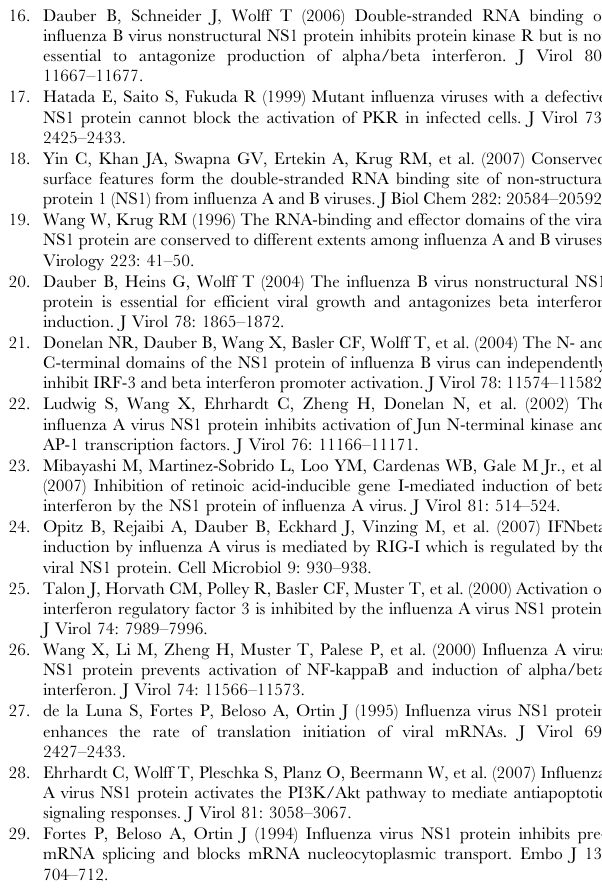
Figure S1 Pathogenicity of influenza B viruses expressing dsRNA-binding defective NS1 proteins is enhanced in PKR null mice. (A) Groups of eight-week-old female PKR 2 / 2 and wild type C57B6 mice were anesthetized and infected intranasally with 1 6 10 5 pfu of the indicated recombinant influenza B/Lee virus. For monitoring of viral disease, 8 animals were weighed daily for two weeks, and mean percentage weight loss of each group was compared with the weight immediately prior to infection. Mice were euthanized when observed in extremis. (B) Survival rate of PKR 2 / 2 mice after infection with recombinant influenza B viruses. Dead animals were scored daily and represented as the percentage of surviving animals. Figure S2 Preparation of vRNPs from recombinant influenza B/Lee virus. Virus was grown in embryonated chicken eggs and subjected to lysis and centrifugation over a discontinuous glycerol gradient as described in Text S1. Fractions were taken from top to bottom and analyzed by SDS-PAGE and Coomassie blue staining (upper panel) and immunblotting with NP specific antibody